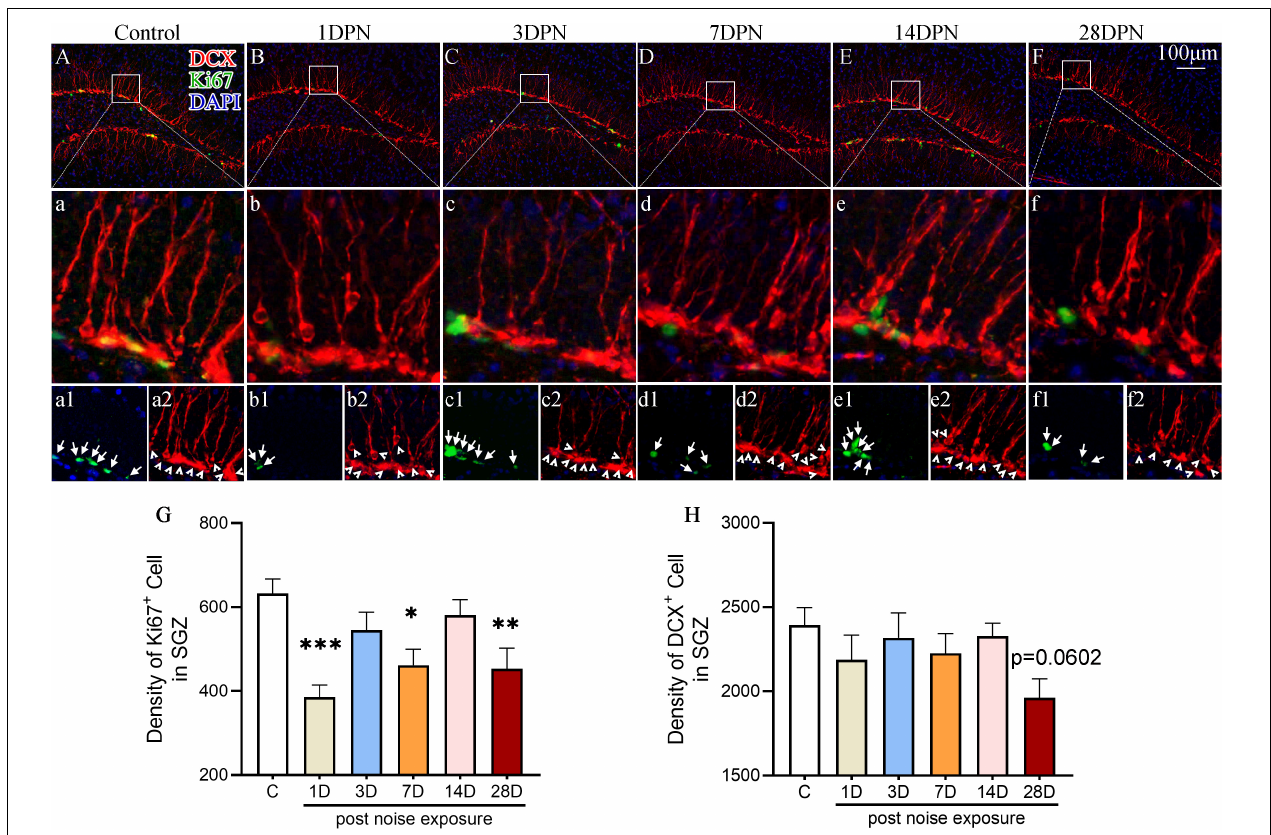
FIGURE 3 | Noise-exposed mice exhibited dynamic changes in hippocampal neurogenesis. (A–F) Representative images of DCX + (red) and Ki67 + (green) cells in the DG of control and noise-exposed mice. Scale bar: 100 µ m. The white rectangle shows the field of view that is shown in the row (a–f) below in higher magnification and the third row (a1–f2) for Ki67 + cells (green, indicated by arrows in a1–f1 ) and DCX + cells (red, indicated by arrowheads in a2–f2 ). (G,H) Quantitative analyses of Ki67 + cells (G) and DCX + cells (H) in the SGZ of each group. The values are presented as the mean ± SEM of 8 mice per group. ∗ p < 0.05, ∗∗ p < 0.01, ∗∗∗ p < 0.001 in post hoc comparisons between the noise-exposed group and the control group following one-way